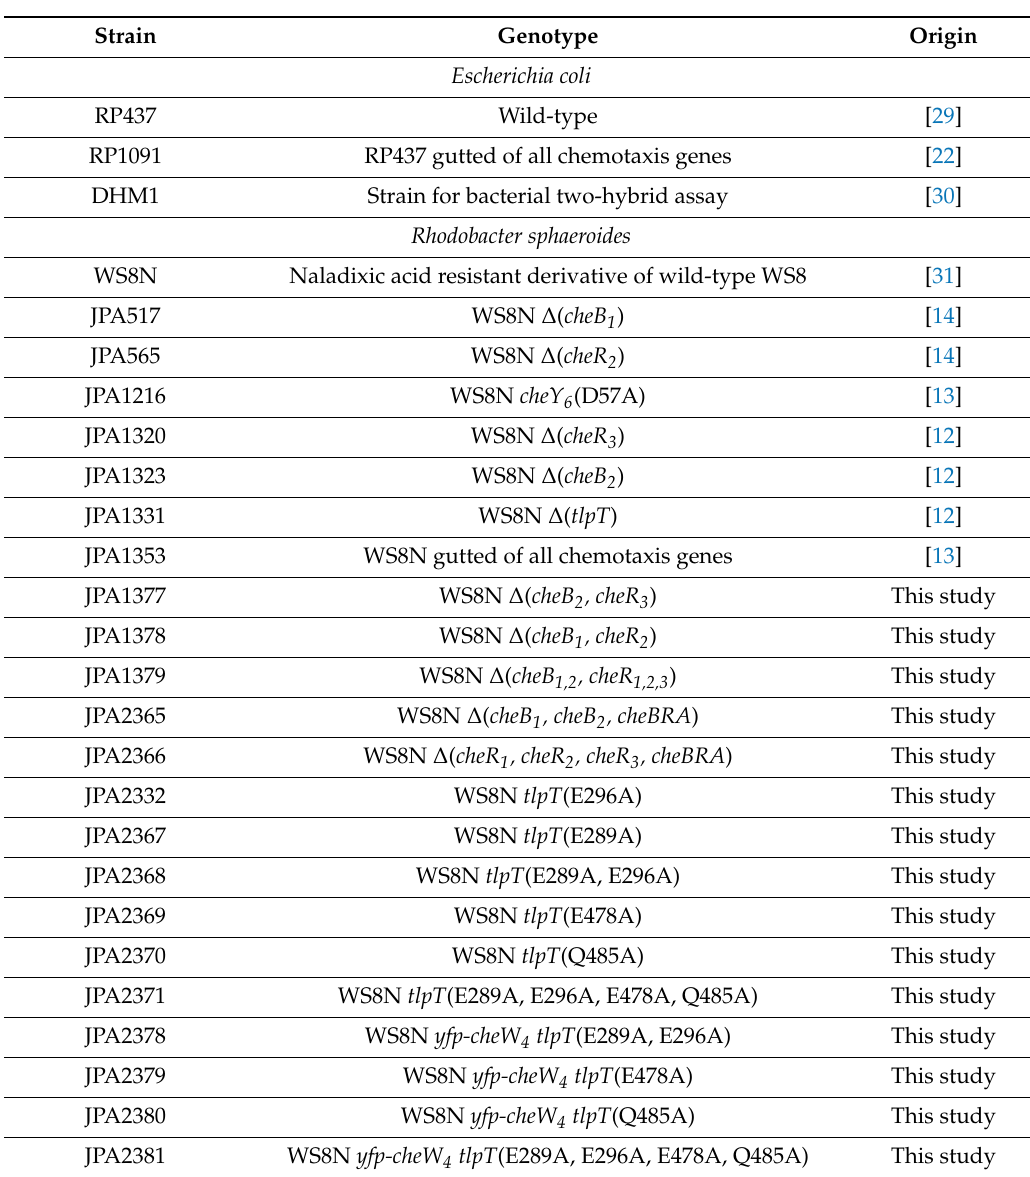
Table 4. Bacterial strains used in this